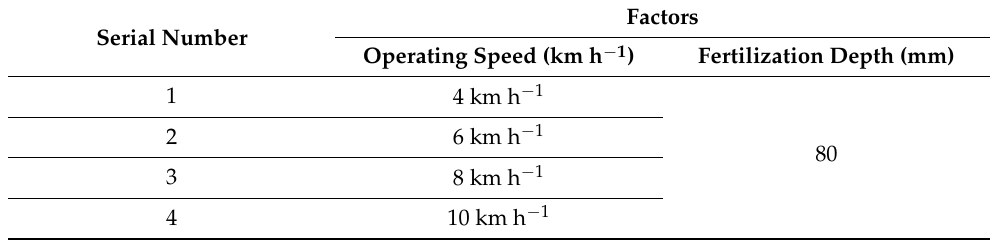
Table 4. Discrete element simulation test conditions.